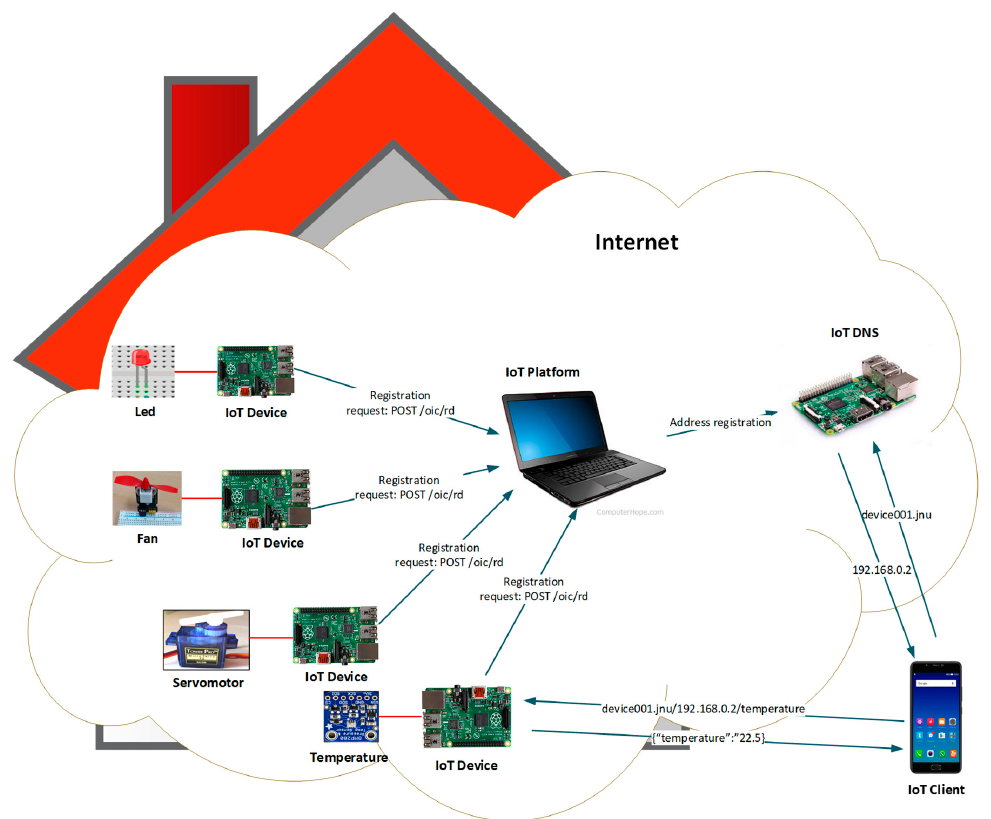
Figure 9. Experimental environment.